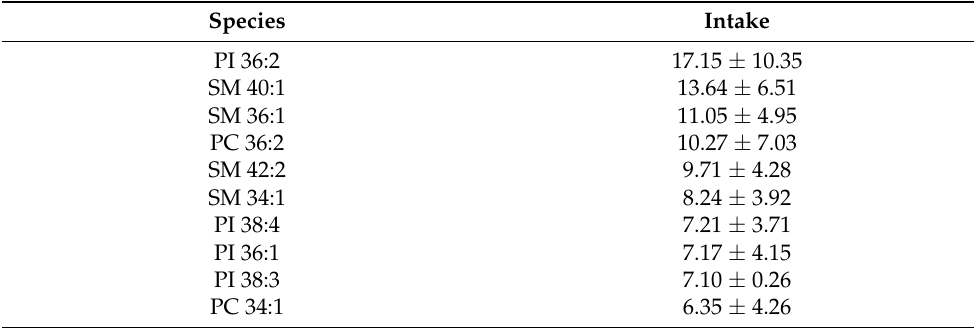
Table 2. The 10 lipid species with the highest mean infant intakes ( µ mol/day).